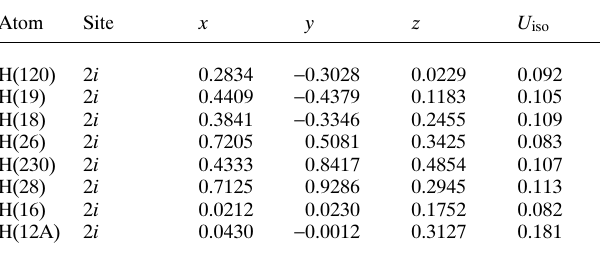
Table 2. Atomic coordinates and displacement parameters (in Å 2 ) .